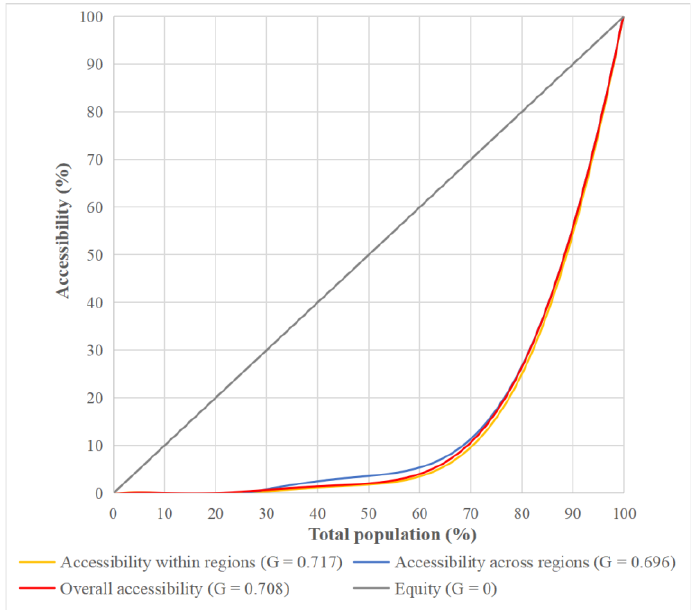
Figure 5. Social equity of accessibility to tertiary hospitals for the total population.